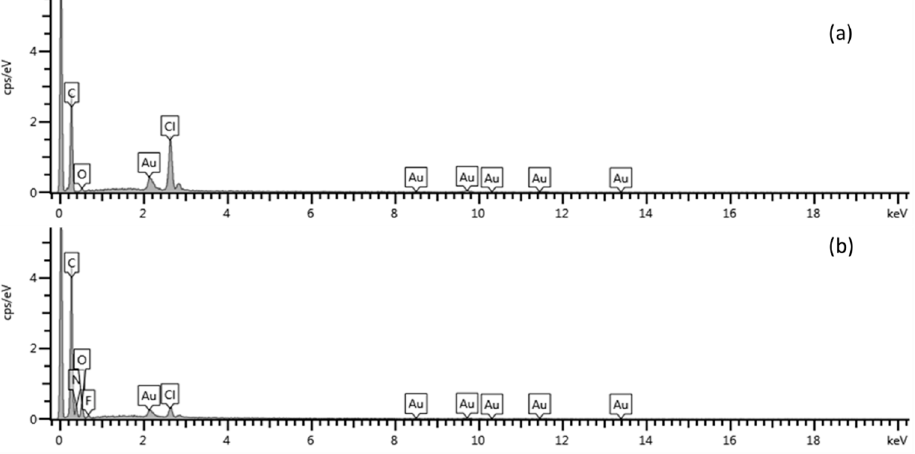
Figure 5. Energy dispersive spectroscopy (EDS) results obtained from HRSEM at the ( a ) bare SPCE and ( b ) NGr-DMG-SPCE.